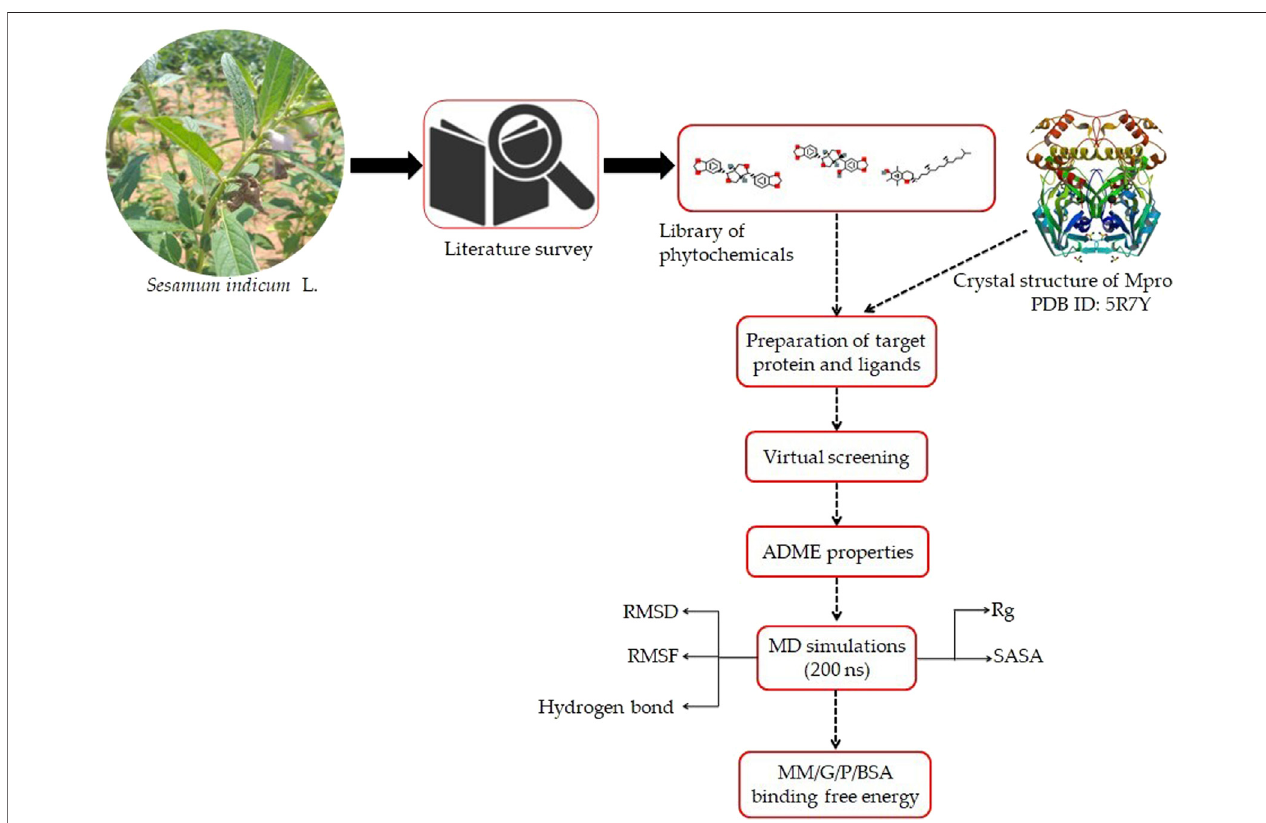
FIGURE 1 | Representation of pipeline utilized in the present study to identify the inhibitors of M pro of SARS-CoV-2 using an extensive molecular modeling approach.